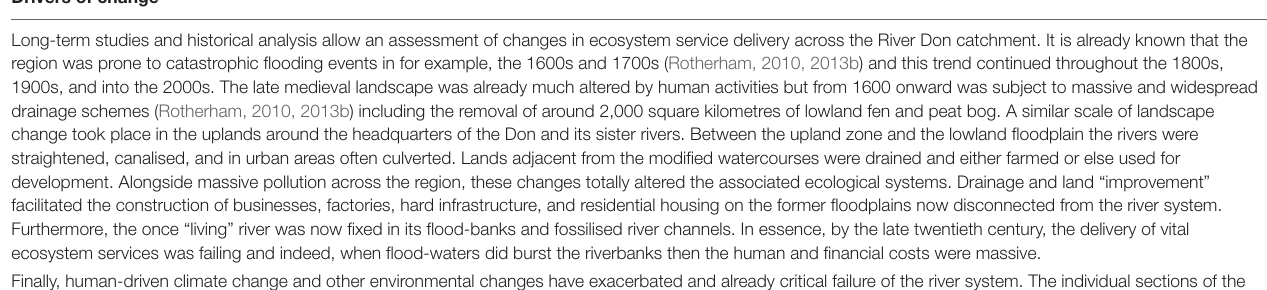
TABLE 2 | Summary of the River Don ecosystem service provision (from Crowe and Rotherham, 2019). Drivers of